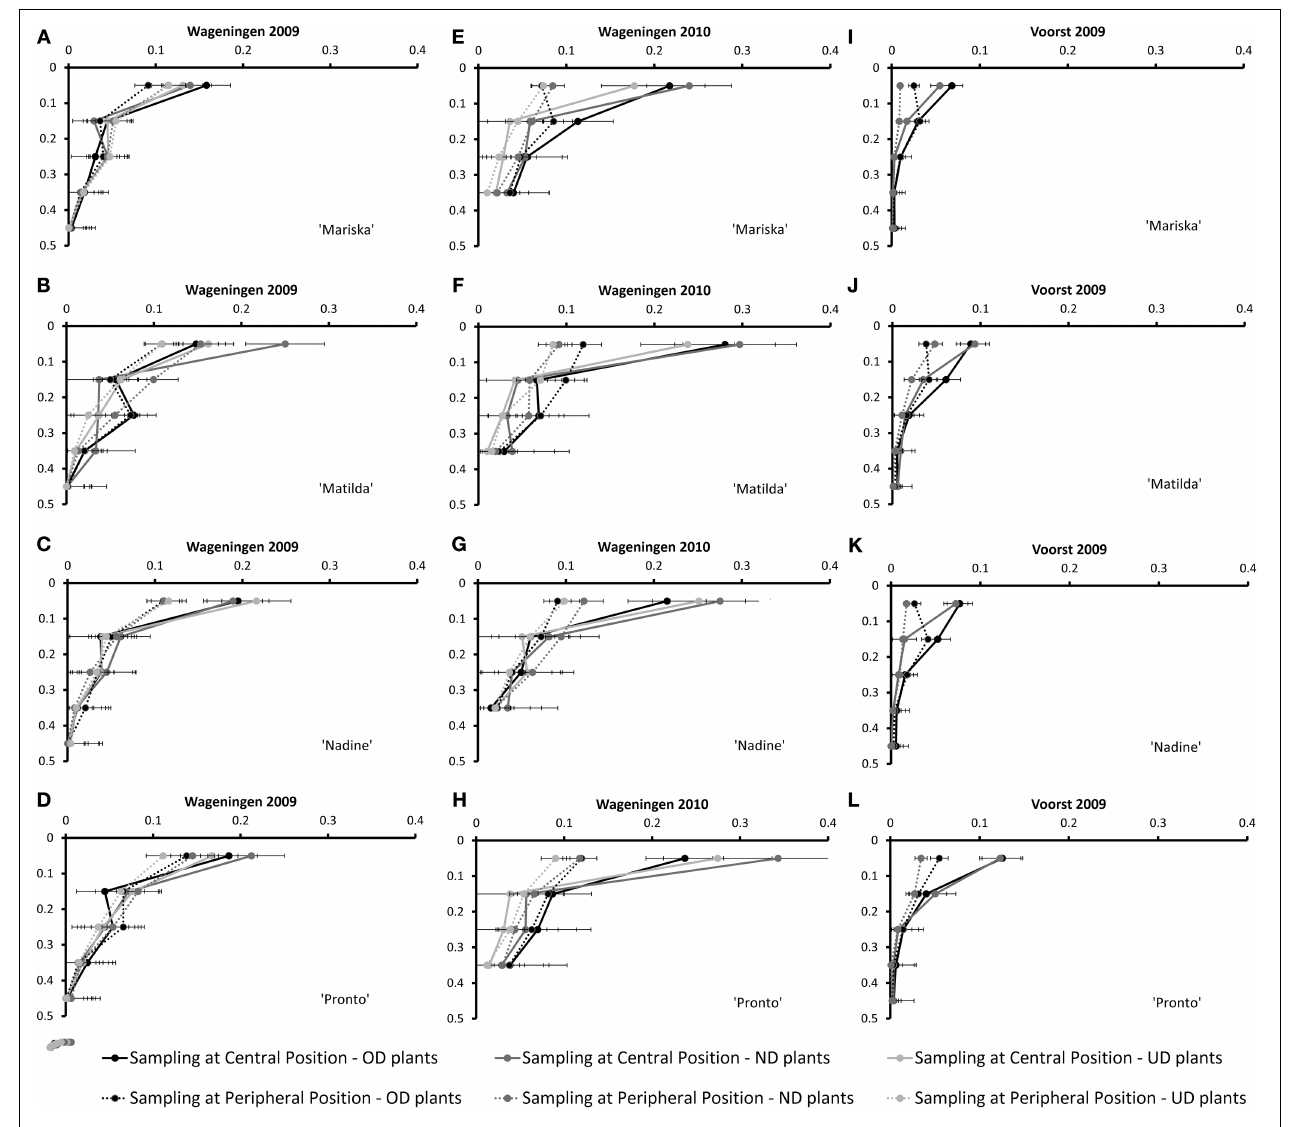
FIGURE 3 | Root Mass Density measured at the Central- and Peripheral positionsatthethirdrootsamplingofthefourcultivarsaveragedoverthe three or two transplant sizes [Over-Developed- (“OD”), Normally